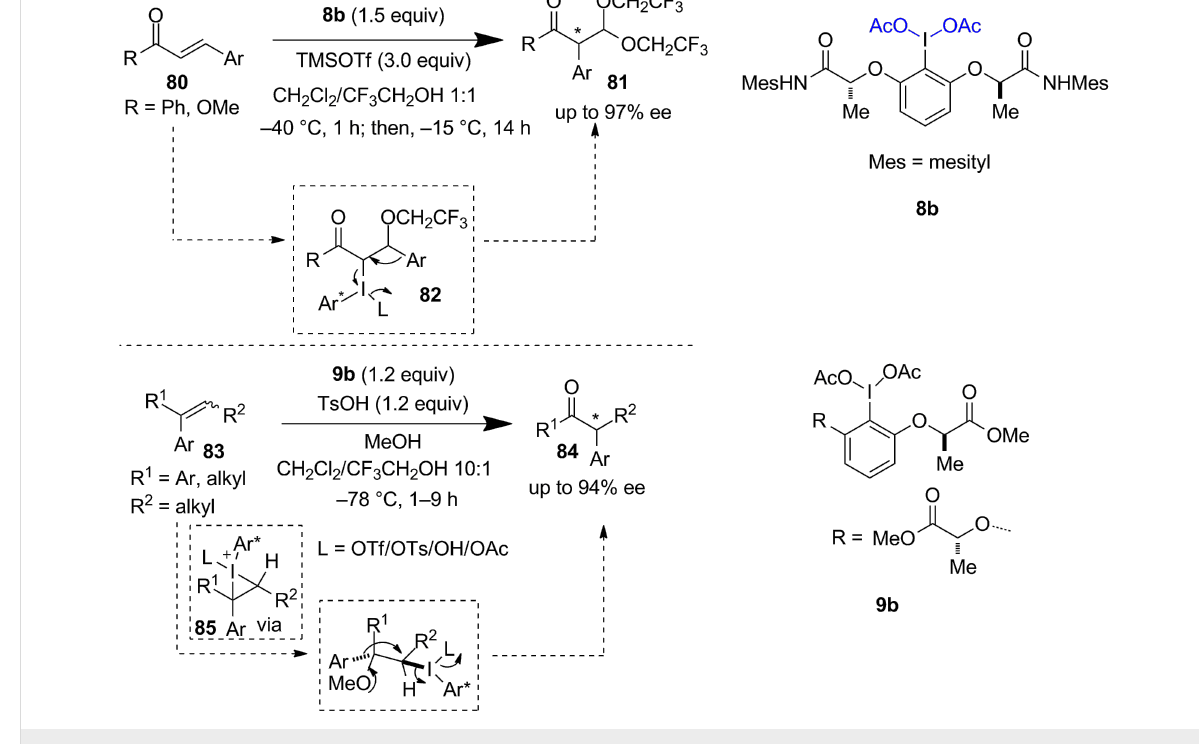
Scheme 16: Aryl rearrangement reported by Wirth et al.